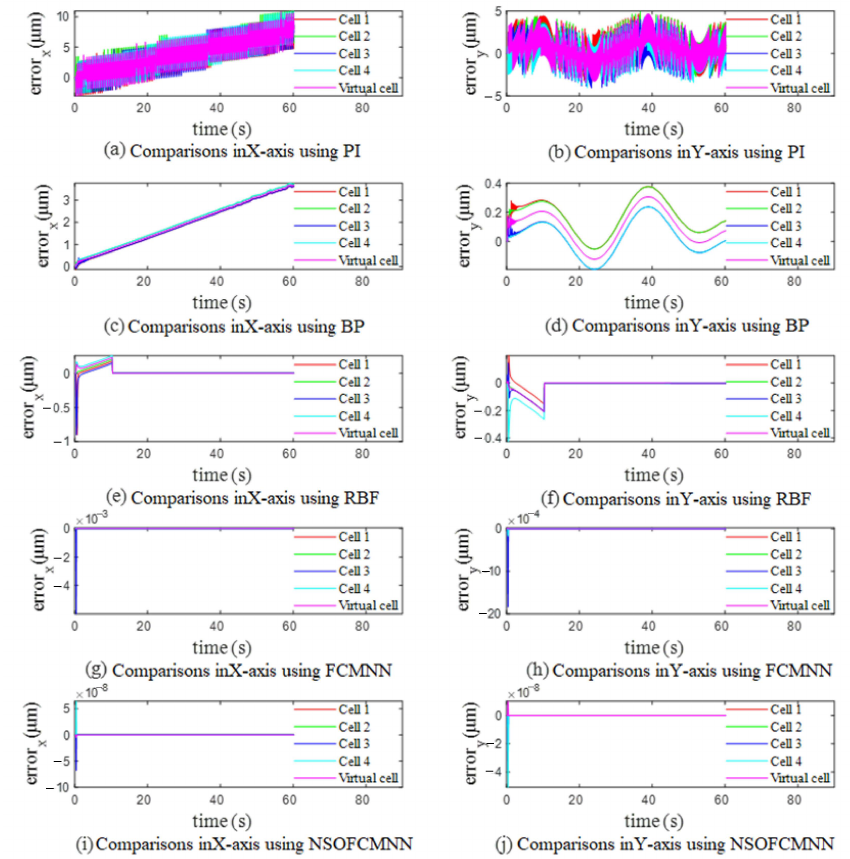
Figure 13. Trajectory error using different controllers (multi-cell